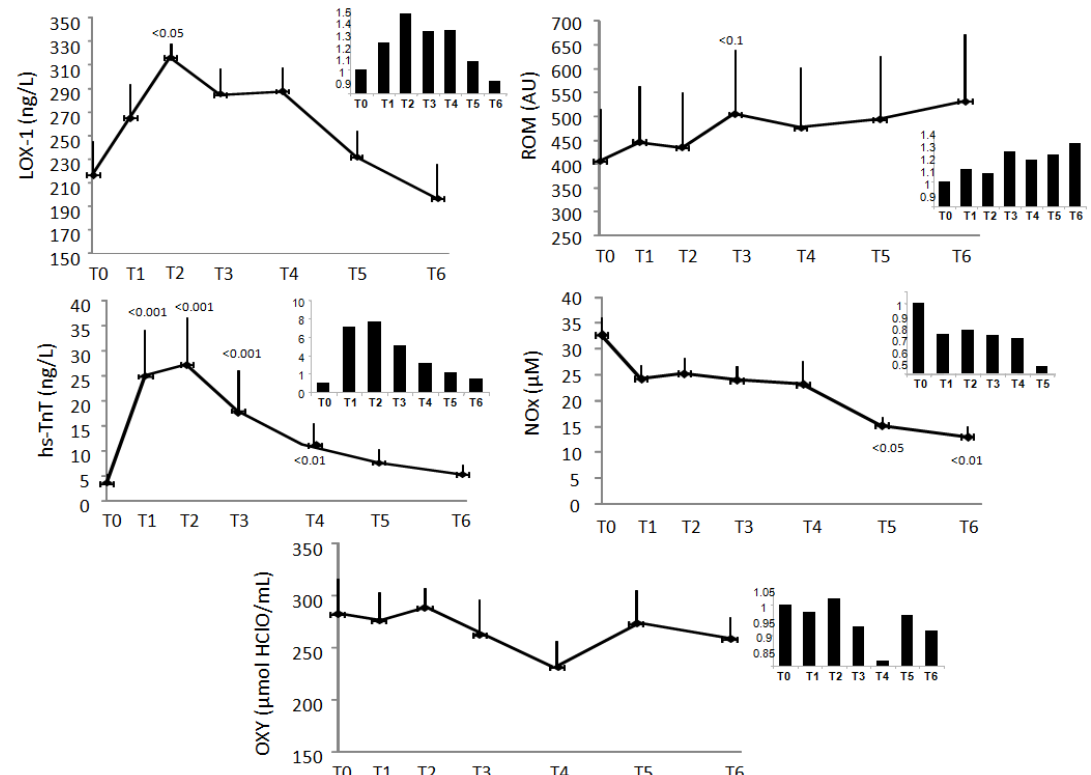
Figure 1. Time response during acute myocardial infarction (AMI) in 15 patients and in the small box